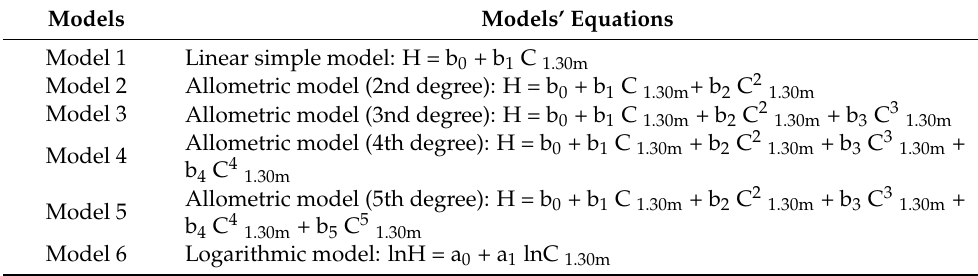
Table 1. Models used to characterize relationship between tree height and circumference at 1.30 m. Where H is the tree height and C1.30 m is the circumference of tree at 1.30 m from the